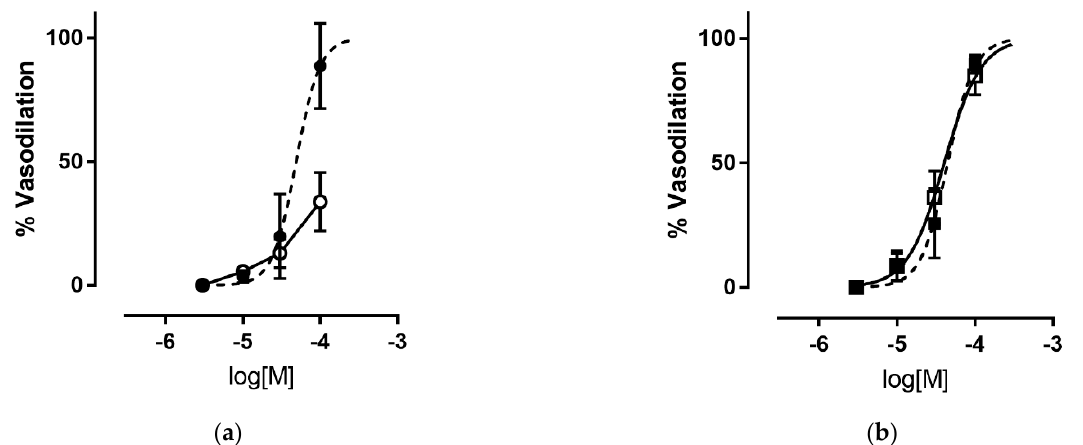
Figure 2. Vasodilating effects on rat aorta strips precontracted with 25 mM KCl: ( a ) 6 (dotted line, ● ), 6 and 10 µM glibenclamide (straight line, ○ ); ( b ) 8 (dotted line, ■ ), 8 and 10 µM glibenclamide (straight line, □ ).